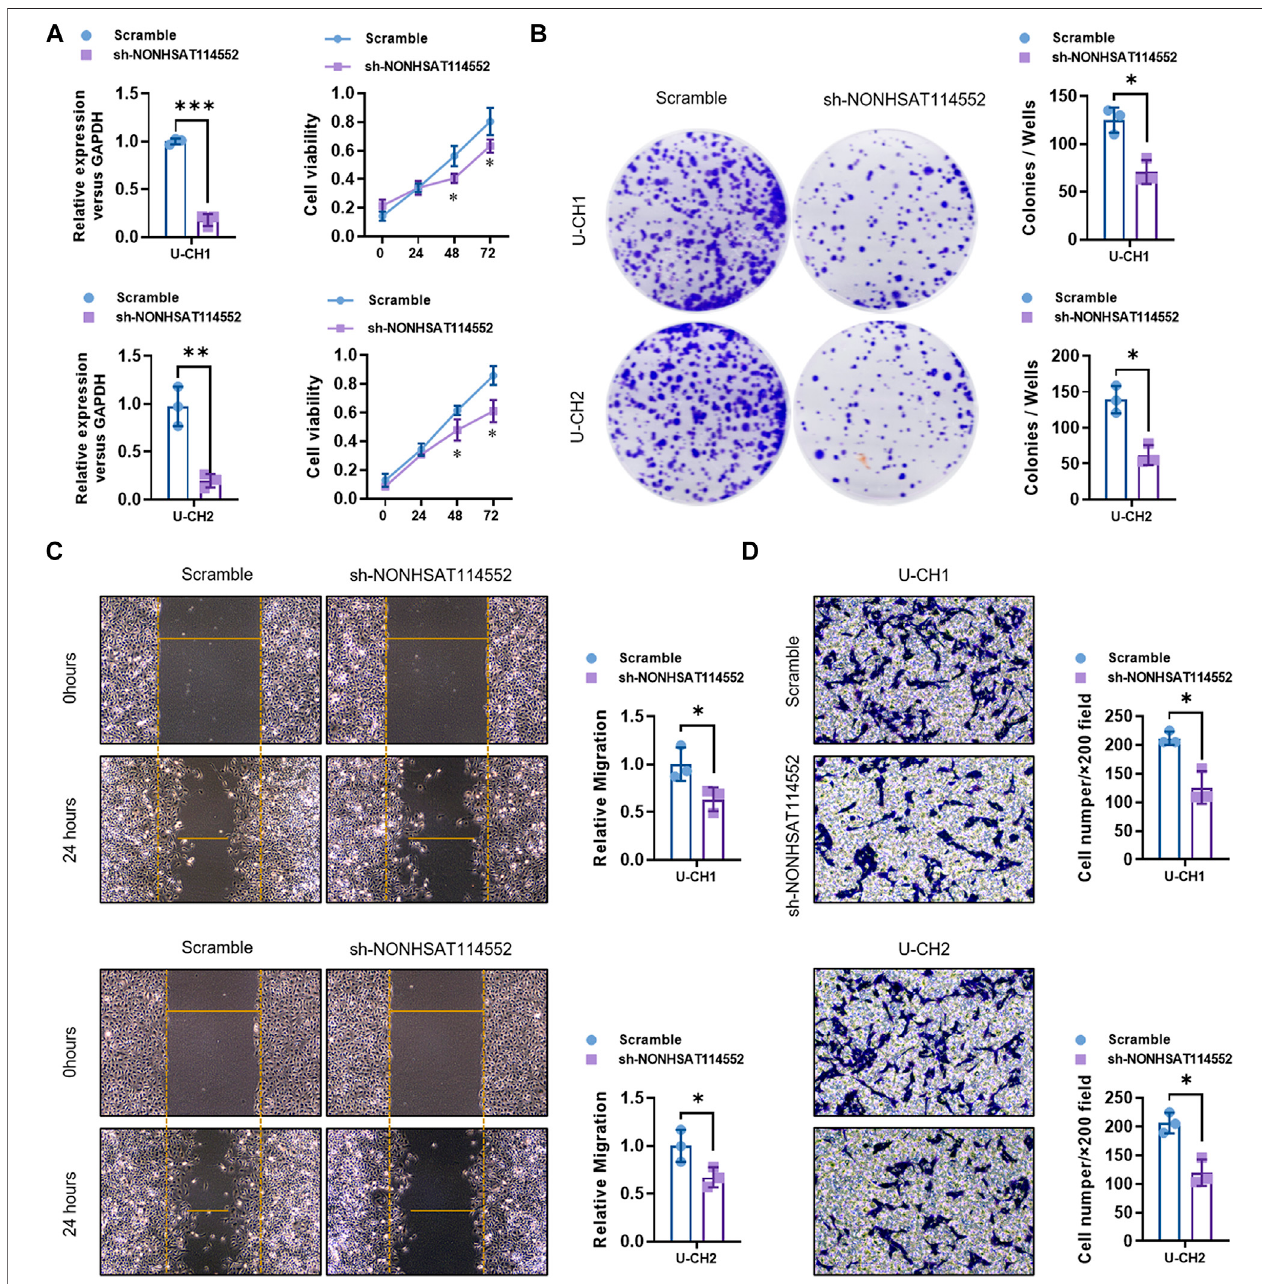
FIGURE 2 | Knockdown of NONHSAT114552 affected chordoma cells (U-CH1 and U-CH2) proliferation, invasion and migration (A) . Left, NONHSAT114552 relative expression was assessed after U-CH1 or U-CH2 cells were transfected with sh-NONHSAT114552. Right, knockdown of NONHSAT114552 signi fi cantly inhibited U-CH1 or U-CH2 cell viability (B) . Colony formation assays showed that knockdown of NONHSAT114552 signi fi cantly restrained the proliferation of U-CH1 or U-CH2 cells (C) . Wound healing assays demonstrated that deletion of NONHSAT114552 refrained migration of chordoma cells (D) . Transwell assays were conducted for assessing U-CH1 or U-CH2 cell invasion with NONHSAT114552 knockdown.